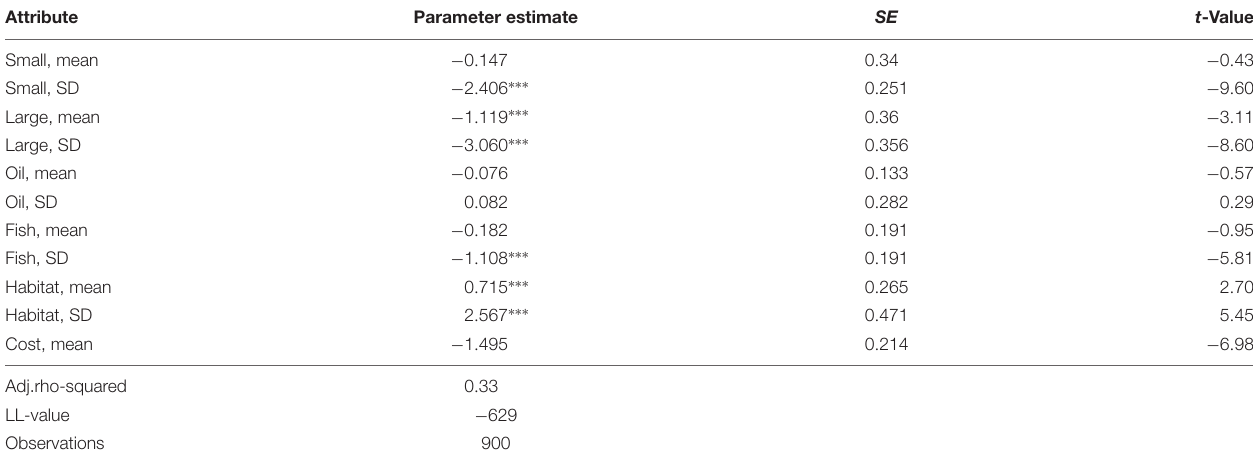
TABLE A1 | Mixed MNL model for coral dataset.